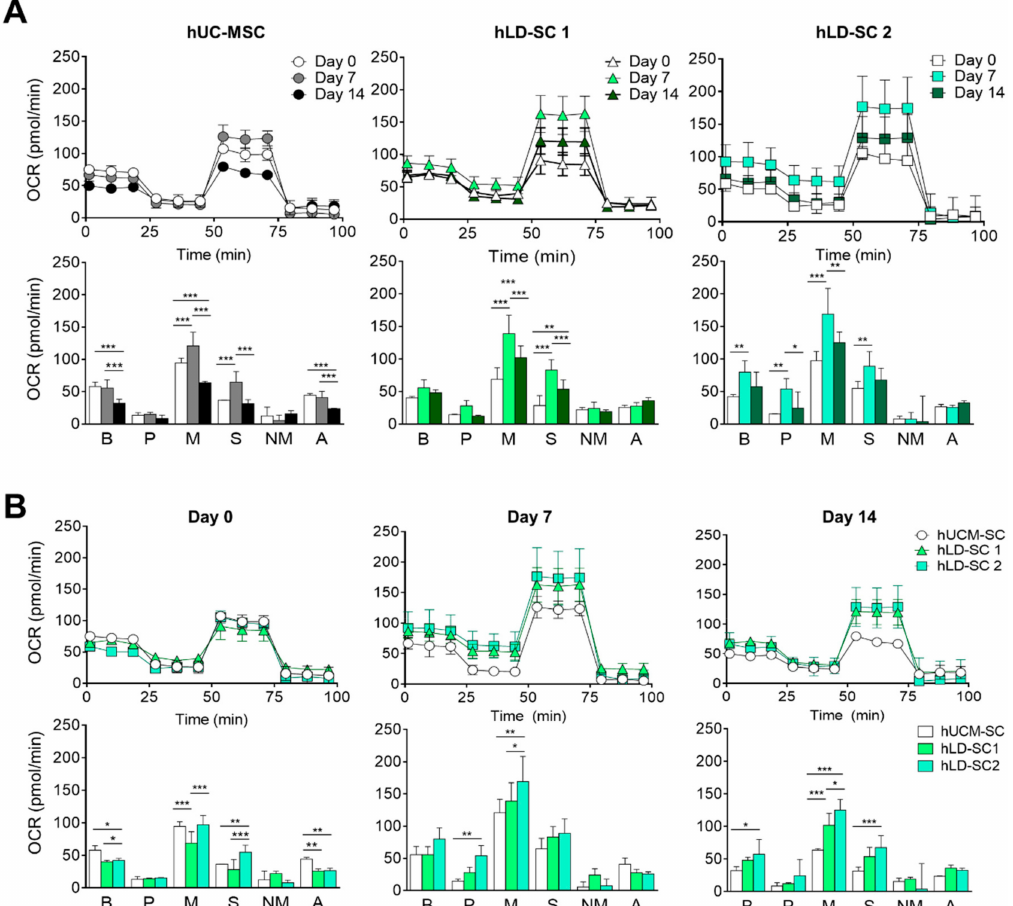
Figure 4. Mitochondrial oxygen consumption rates (OCRs) and biogenetic profiles of stem cells during hepatic di ff erentiation. ( A ) OCRs during the seahorse assay and mitochondrial biogenic profiles of hUC-MSCs and two hLD-SCs on days 0, 7, and 14 of di ff erentiation towards hepatic fate are presented. ( B ) OCRs during the seahorse assay and mitochondrial biogenic profiles on days 0, 7, and 14 of di ff erentiation towards the hepatic fate of hUC-MSCs and two hLD-SCs are presented. B, basal respiration; P, proton leak; M, maximal respiration; S, spare respiratory capacity; NM, non-mitochondrial oxygen consumption; A, ATP production. P -values < 0.05 were considered significant. n = 4. *, p < 0.05; **, p < 0.01; ***, p <